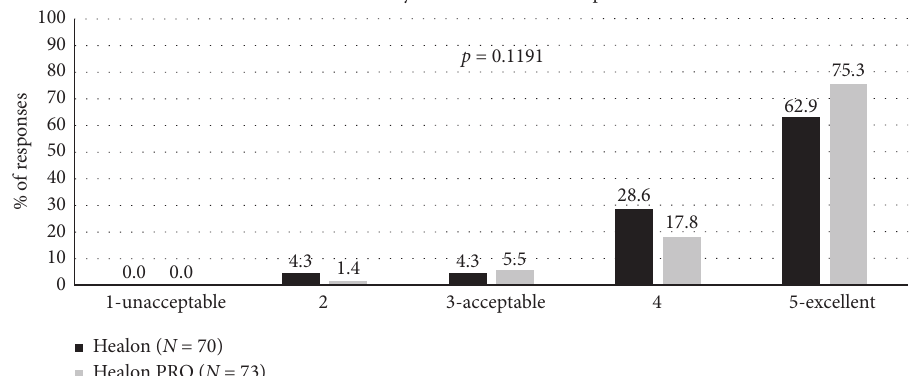
Figure 6: Tissue manipulation during surgery for the Healon control and Healon PRO test groups, where “user acceptable” indicated a response of “3,” “4,” or “5.”